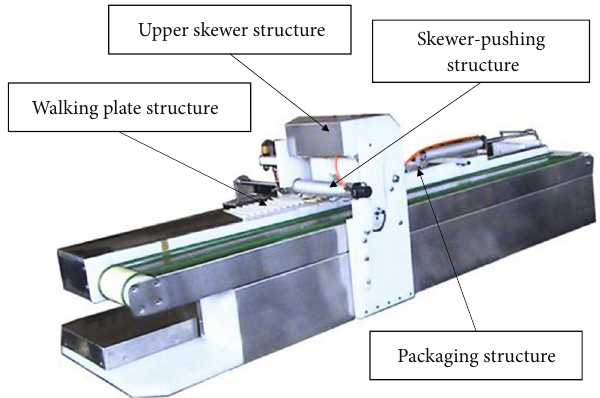
Figure 6: An automatic threading